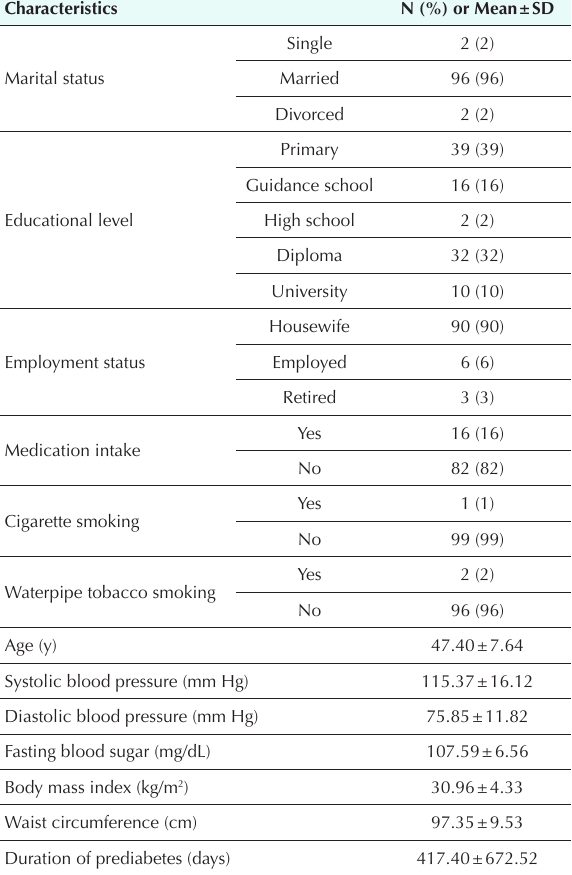
Table 1. Participants’ characteristics